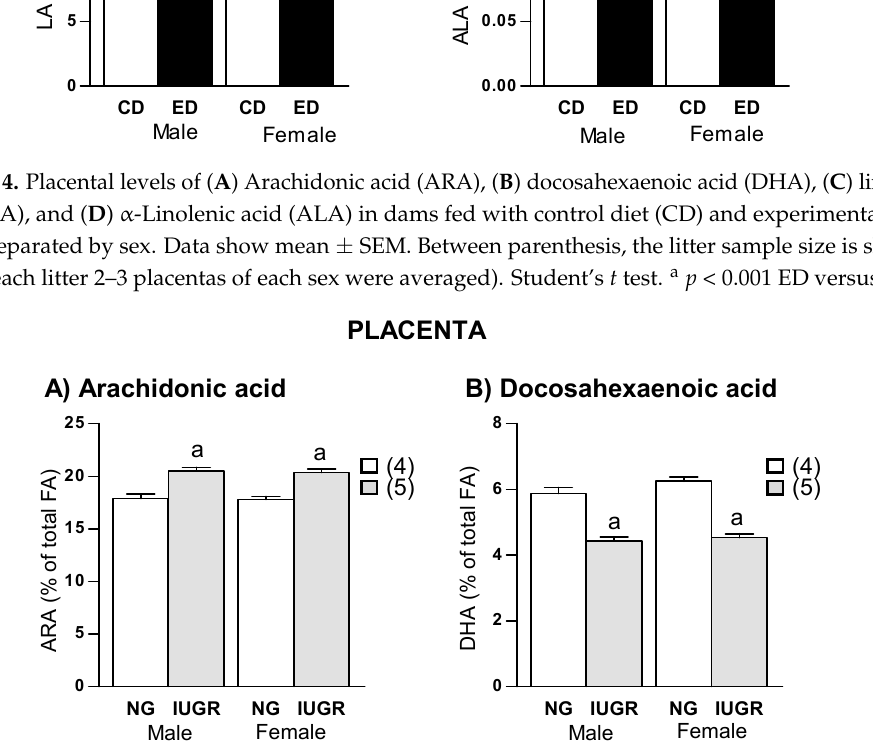
Figure 5. Relationship between fetal growth and placental levels of ( A ) arachidonic acid (ARA) and ( B ) docosahexaenoic acid (DHA) in experimental diet, separated by sex. NG, Normal growth; IUGR, Intrauterine growth restriction. Data show mean ± SEM. Between parenthesis, the litter sample size is shown. ANOVA. a p < 0.001 IUGR versus NG.